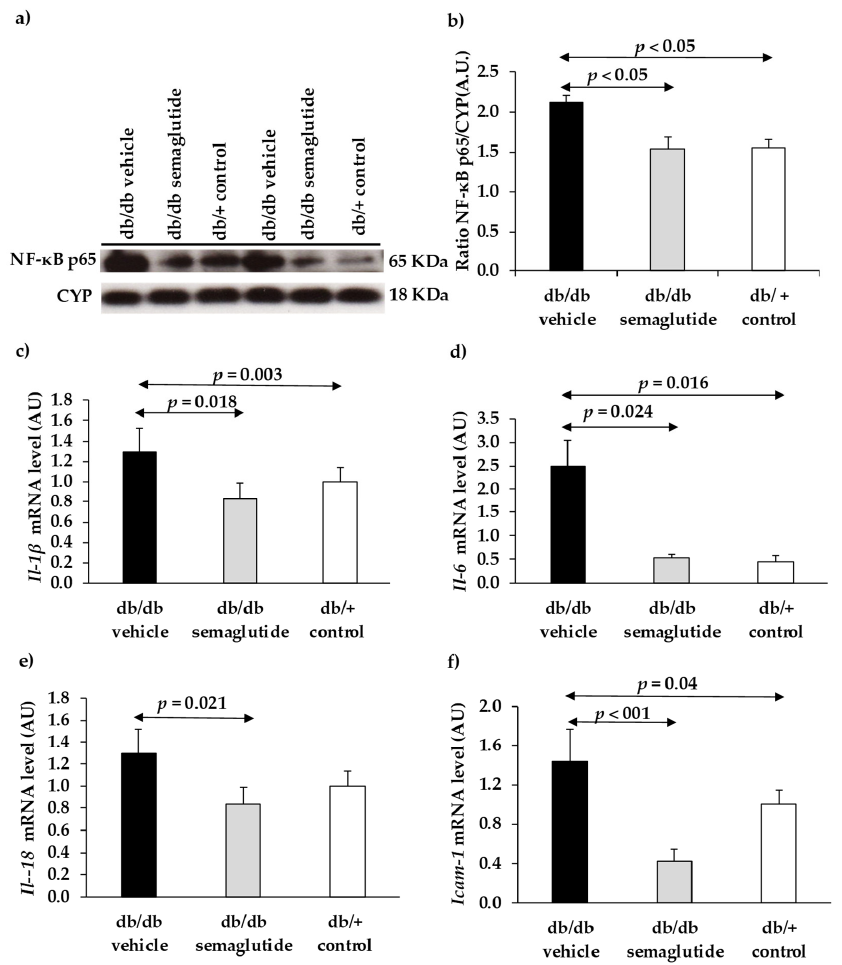
Figure 5. Effect of semaglutide eye drops on retinal inflammation. ( a ) Western blotting bands of NF- κ B (p65). ( b ) Densitometric analyses in mouse retinas in db/db mice treated with vehicle (black bar), db/db mice treated with semaglutide (grey bar) and non-diabetic mice (white bar). ( c – f ) Real-time quantitative reverse transcription polymerase chain reaction (RT-PCR) analysis of IL-1 β ( c ), IL-6 ( d ), IL-18 ( e ), and ICAM-1 ( f ).